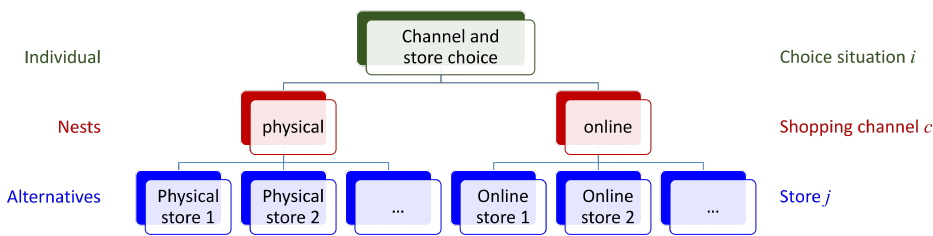
Figure 1: Nested logit approach for store choice including physical and online stores Source: own